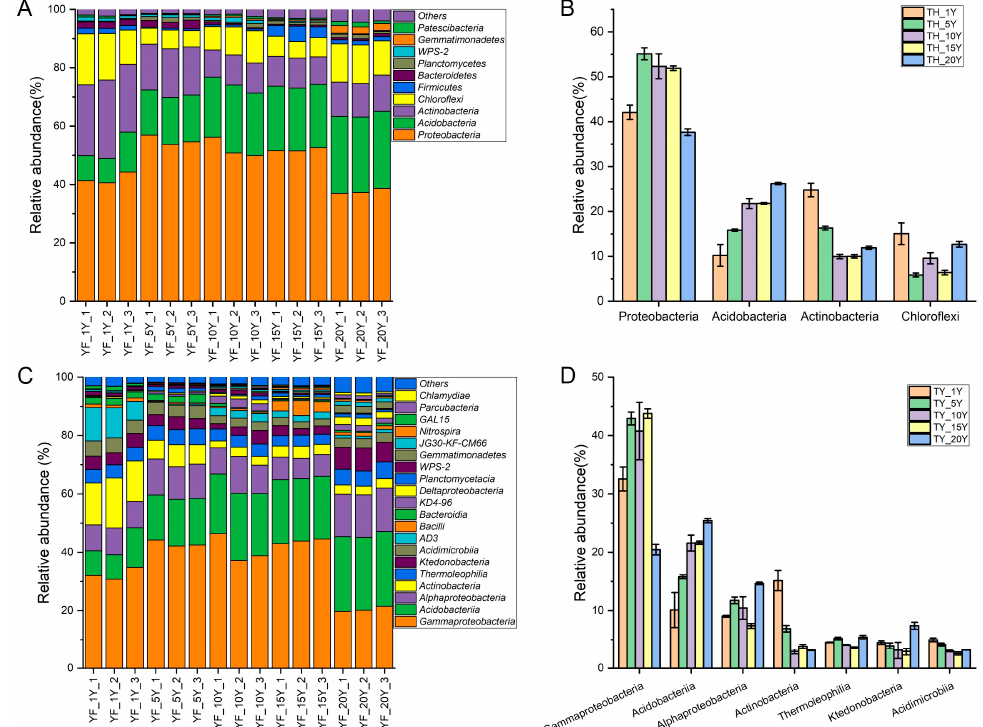
Figure 3. Relative abundance of bacterial communities. ( A ) Phyla are presented in bar plots showing the bacterial variation during different continuous cropping times of yam. ( B ) The relative abundance of the main phyla in soil samples. ( C ) Classes are presented in bar plots showing the bacterial variation during different continuous cropping times of yam. ( D ) The relative abundance of the main classes in soil samples.